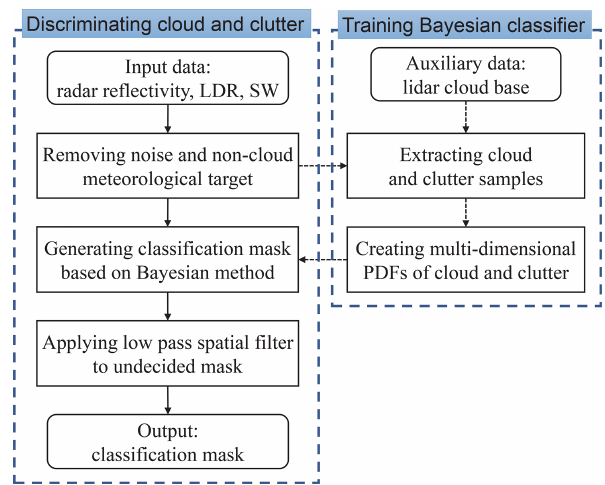
Figure 1. Schematic flow diagram for cloud and clutter discrimina- tion. The right panel (connected by dashed arrows) is only executed once to train the Bayesian